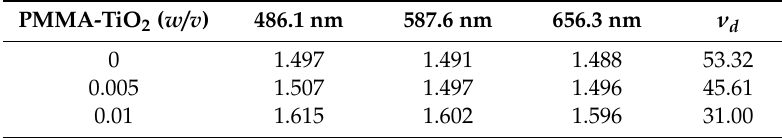
Figure 4. Variation of refractive index with TiO 2 content at specific wavelengths. Table 2. Refractive index and Abbe number of the prepared samples. Table 2. Refractive index and Abbe number of the prepared samples.